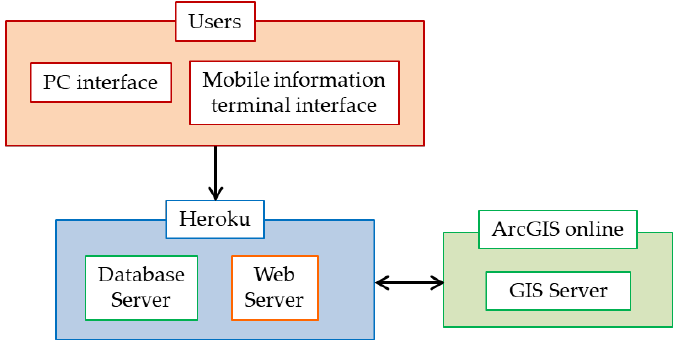
Figure 2. System operating environment.